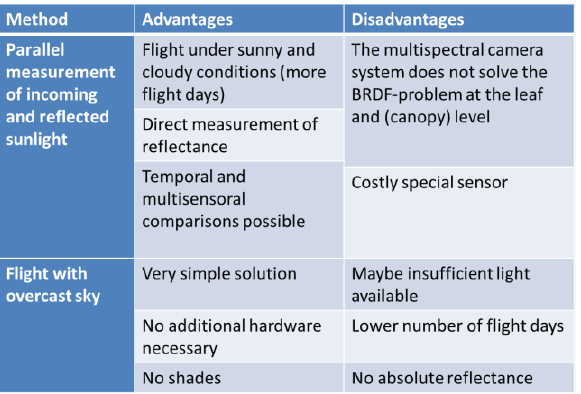
Flying below the clouds can greatly simplify spectral calibration, since the bi-directional reflection properties (BRDF) of the direct sunlight do not have to be taken into account and